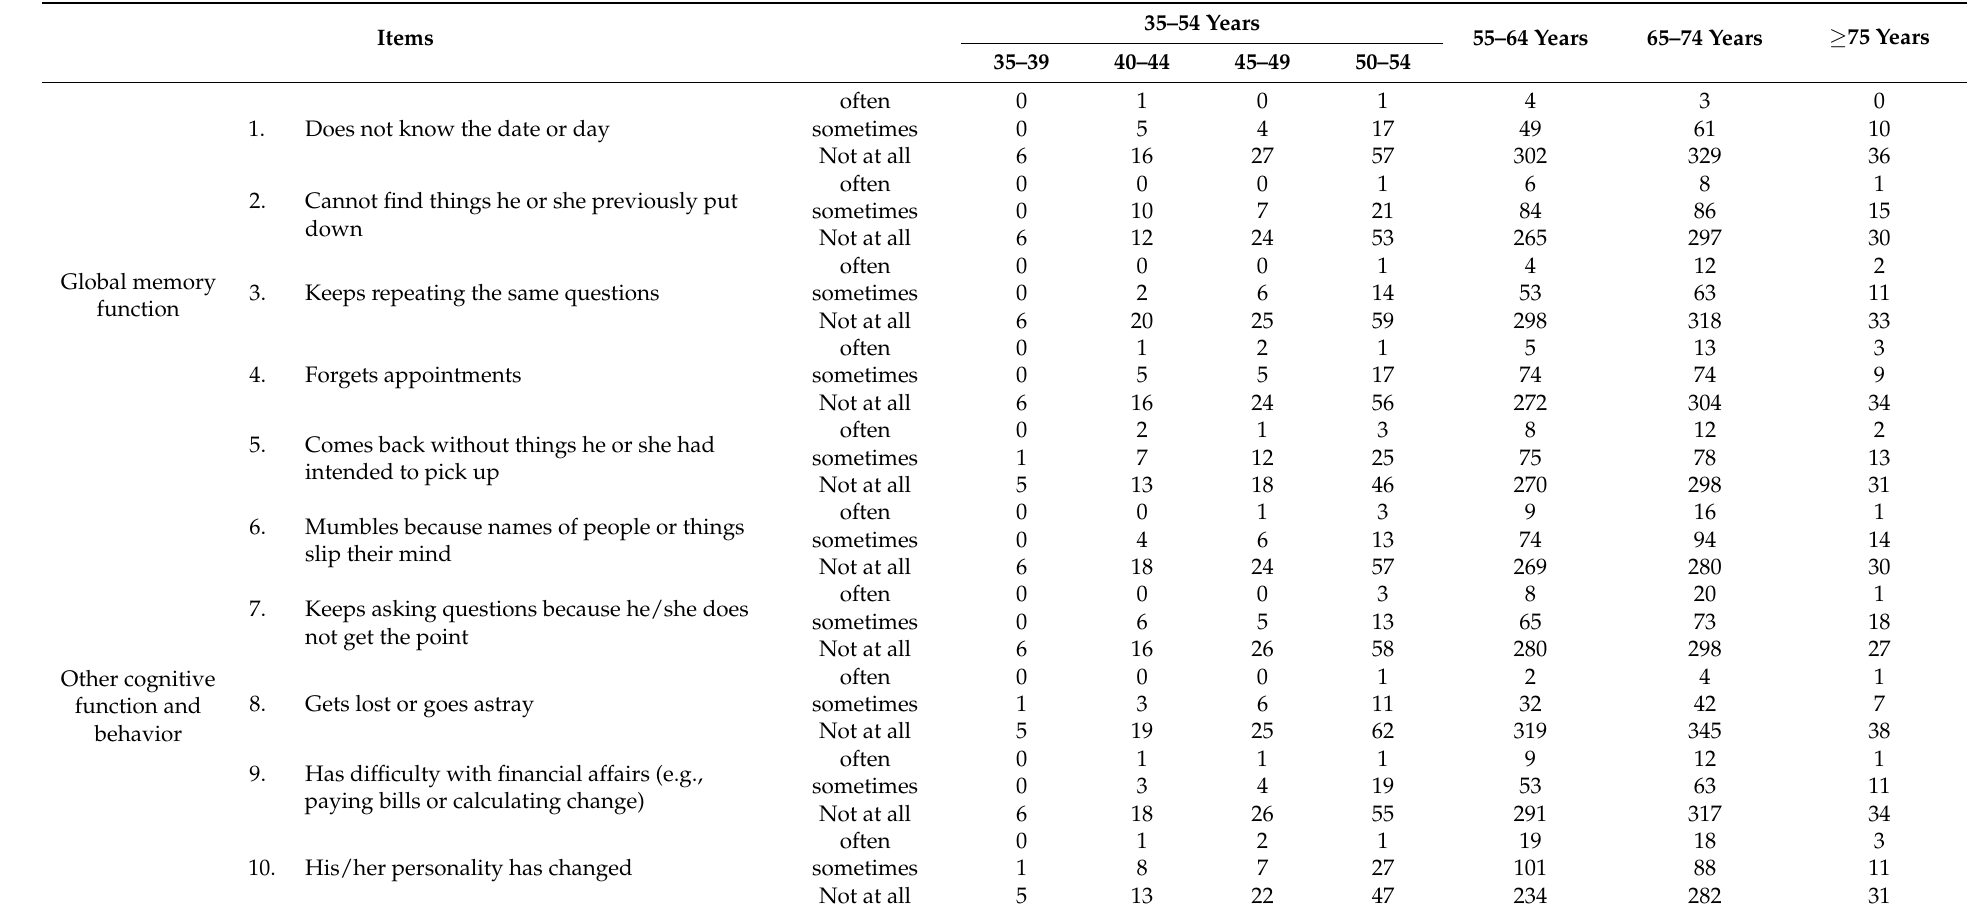
Table 1. Korean dementia screening